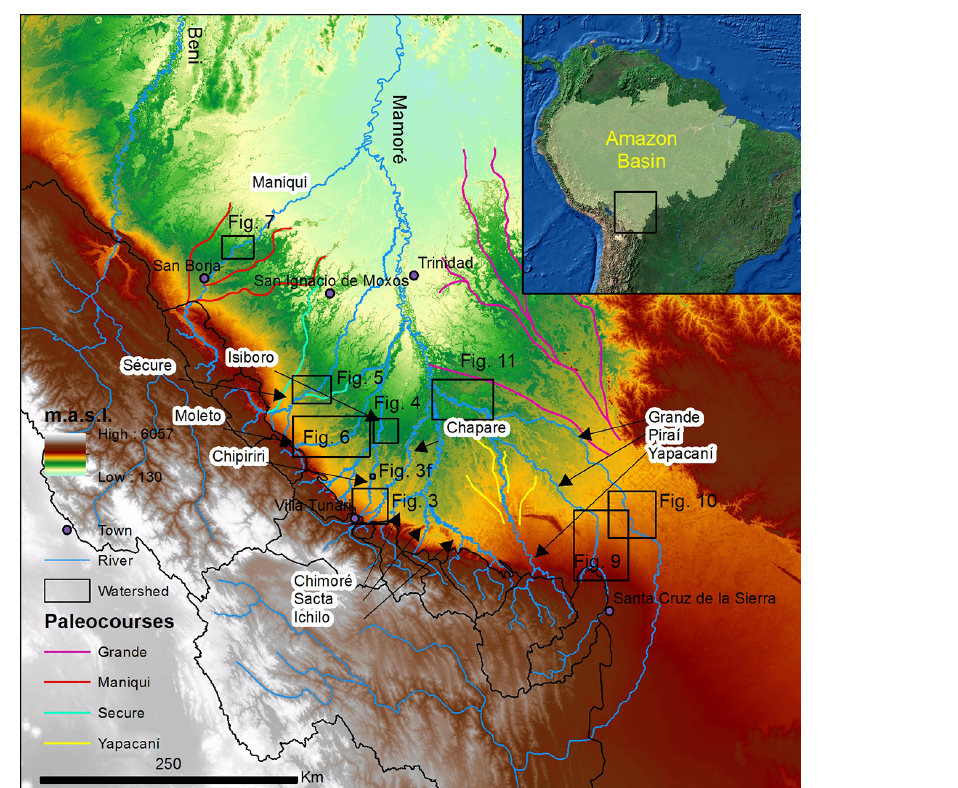
Figure 1. The southern Amazonian foreland basin (SAFB) and the Río Mamoré network. The rivers studied include all the tributaries of the Río Mamoré that have part of their catchment in the Andes. Out of the 12 rivers studied, nine are located in the seasonally flooded savannah of the Llanos de Moxos: the Maniqui, Sécure, Moleto, Isiboro, Chipiriri, Chapare, Chimoré, Sacta and the Ichilo. The remaining three, the Grande, the Piraí and the Yapacaní, flow mostly within the Department of Santa Cruz. The Mamoré, together with the Río Beni, provide most of the sediments and water to the Río Madeira, which is the largest tributary of the Amazon River. The Río Beni drains about 70000km 2 of the Andes. The 12 tributaries of the Mamoré drain more than 93000km 2 . Elevation colours are rendered applying histogram equalize